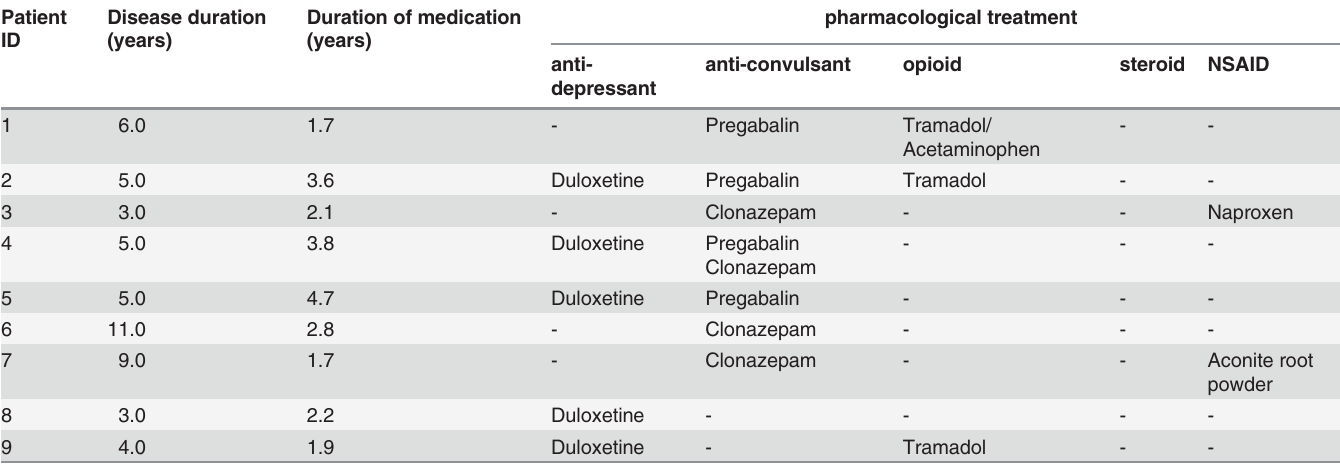
Table 4. Disease and medication history of the FMS patients analyzed in Figs. 5 and 6.